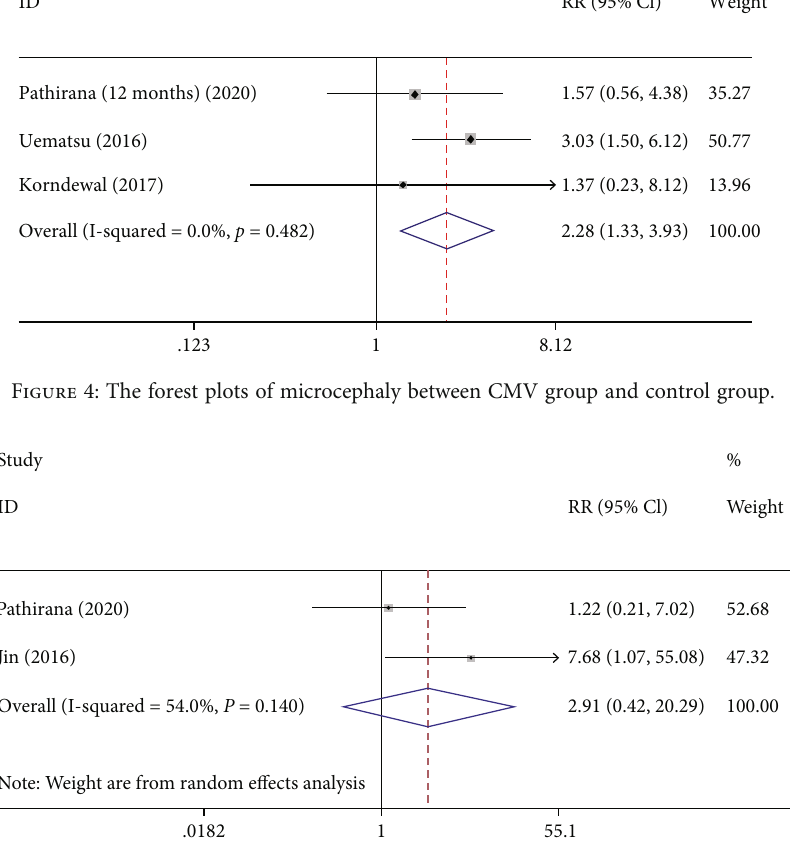
Figure 5: The forest plots of neurodevelopmental delay between CMV group and control